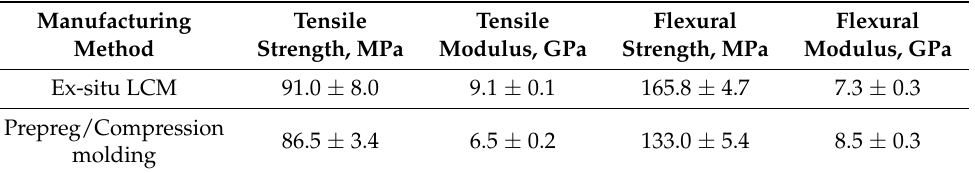
Table 5. Typical mechanical properties of RF composites produced by ex-situ LCM and compression in